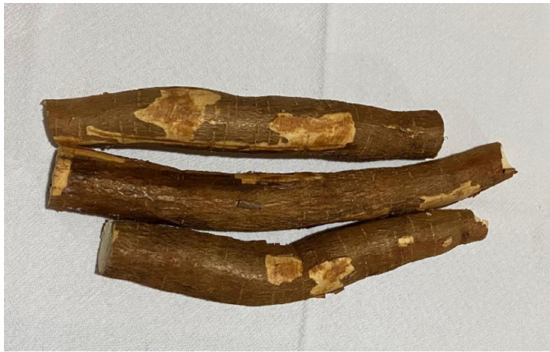
Figure 4. Cassava, Manihot esculenta Crantz. Source: Personal